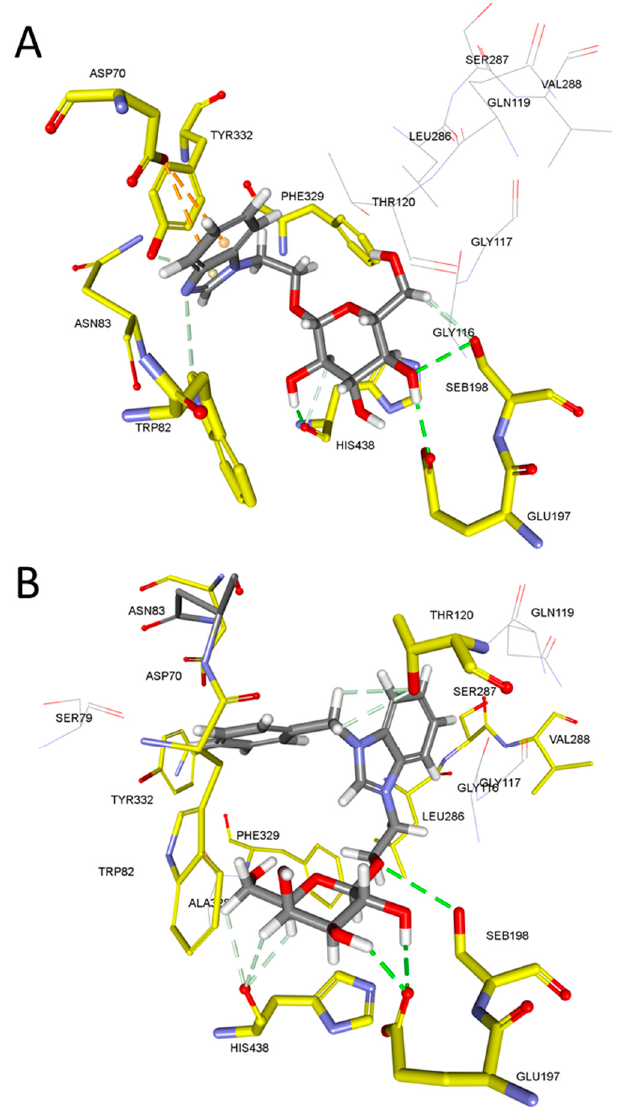
Figure 3. Docked conformation of tested compounds in the active site of the BChE (PDB: 2PM8). Top-ranked conformation of compound 5 ( A ). Top-ranked conformation of compound 14 ( B ). Non-covalent interactions are shown as green or light green dashed lines (H-bonds) and orange dashed lines ( π interactions). Hydrogen atoms of residues are omitted for better visibility, oxygen is red, nitrogen is blue, and carbon is grey or yellow.